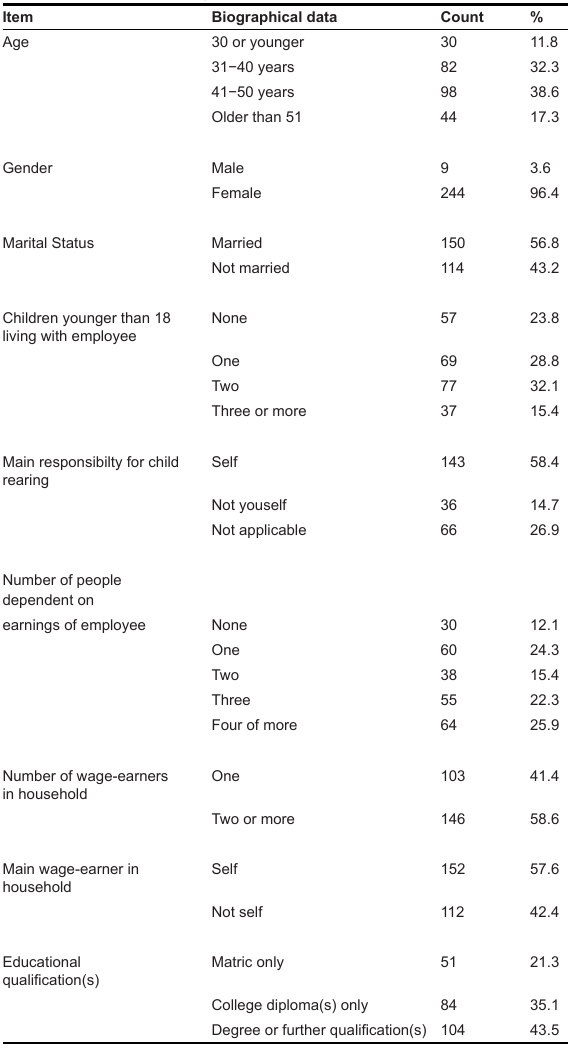
TABLE 2(b) Biographical data of the